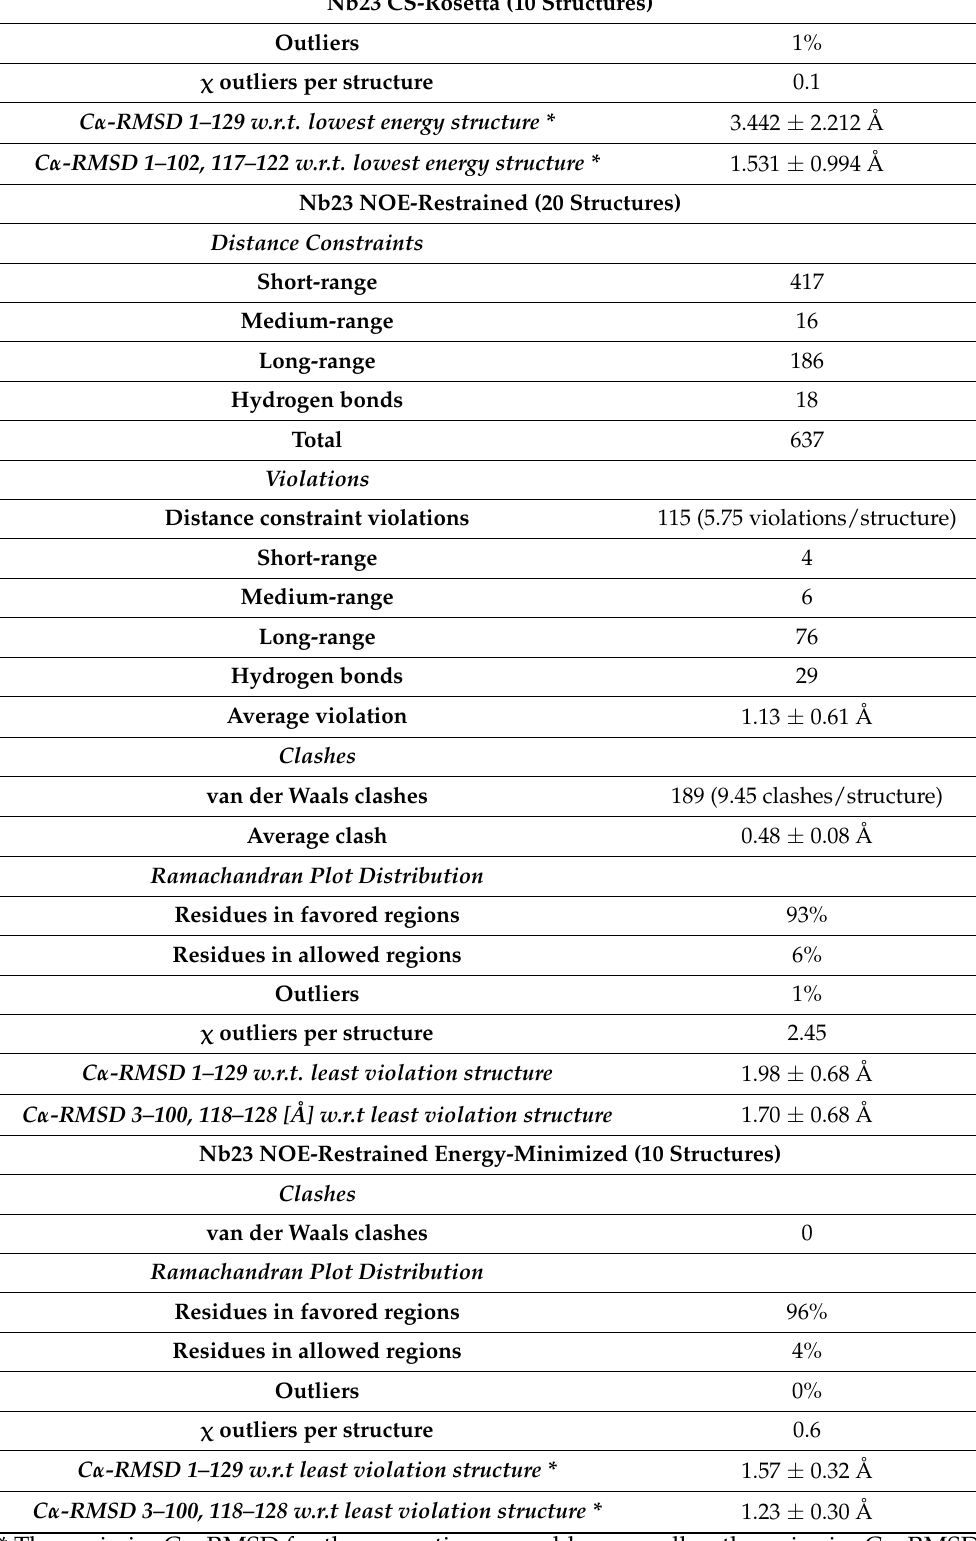
Nb23 CS-Rosetta (10